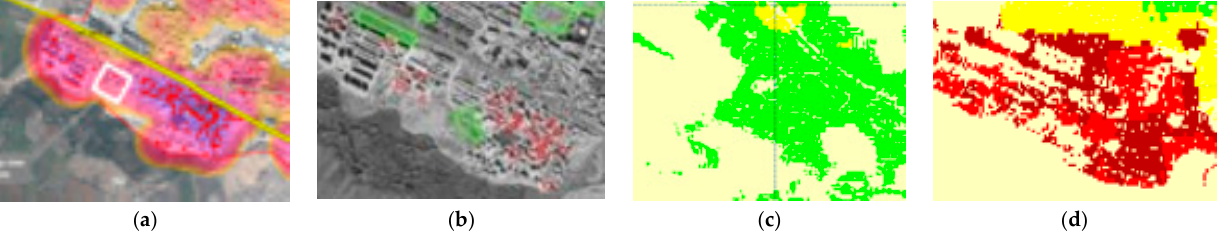
Figure 10. The zoom-in result of multilevel damaged region detection in Sarpol-Zahab. ( a ) GT by UNITAR-UNOSAT, and ( b ) GT by Iranian Space Agency, ( c ) ND-Based method, and ( d ) Proposed Method.